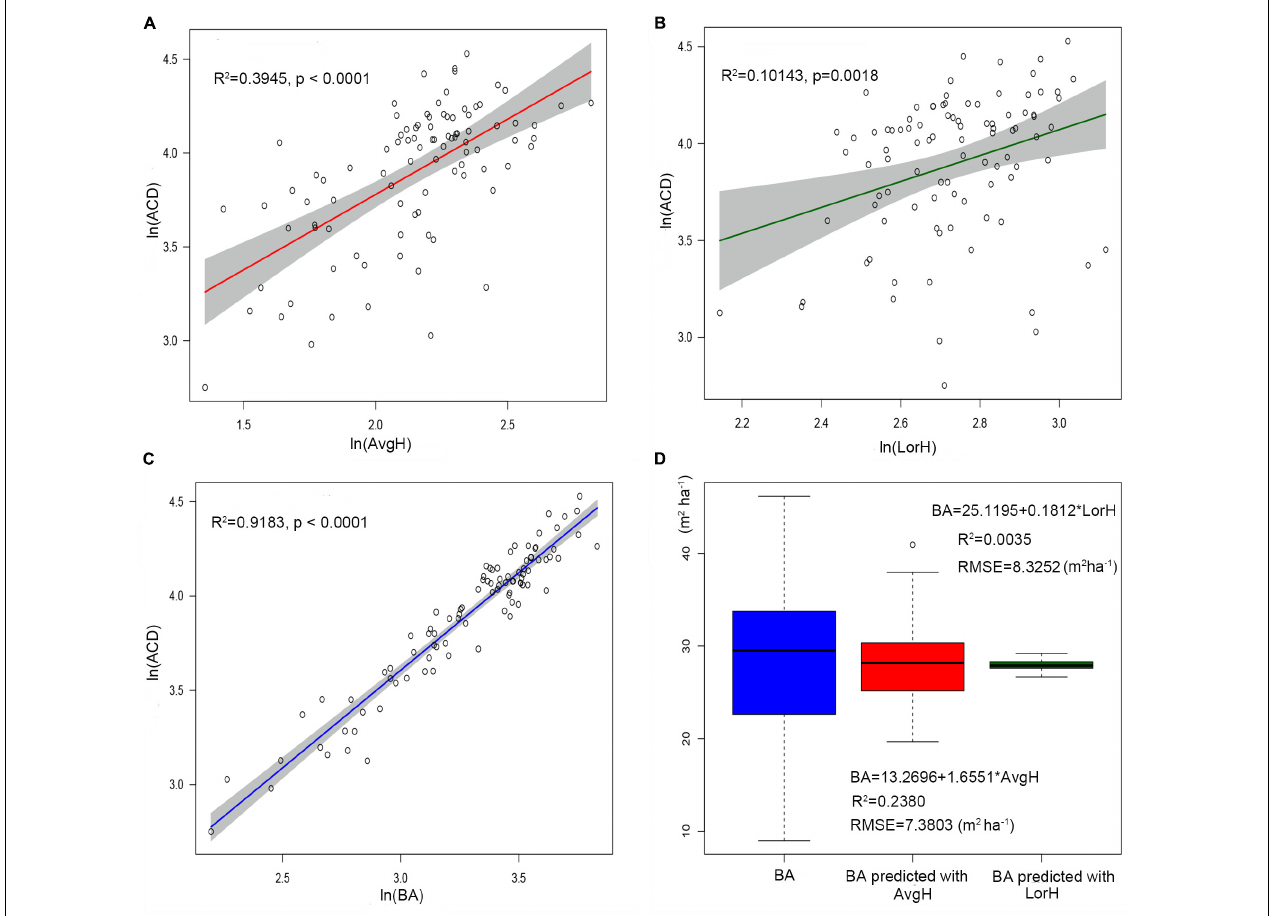
FIGURE 3 | The linear relationship between ln(AvgH) and ln(ACD) (A) , ln(LorH) and ln(ACD) (B) , ln(BA)and ln(ACD) (C) . The shadowed region shows the 95% confidence interval. (D) Boxplots of the field-surveyed BA and predicted BA using plot-averaged height (AvgH) and Lorey’s height